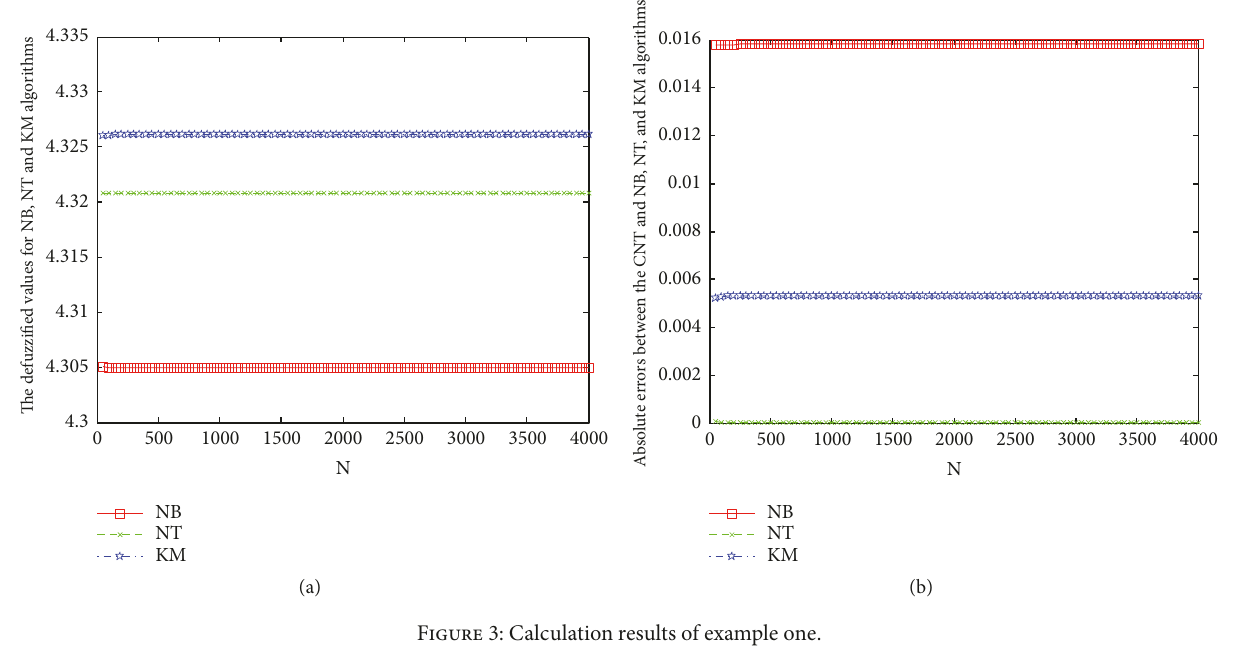
Figure 3: Calculation results of example one.